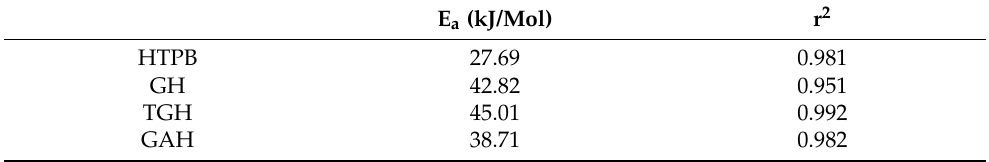
Figure 10. Linear fit of the activation energy of the DOS migration in the different liners by impreg- nation. ( a ) pure HTPB liner; ( b ) GH liner; ( c ) TGH liner; ( d ) GAH liner. Table 3. Migration activation energy of DOS in different liner specimens (dipping method).